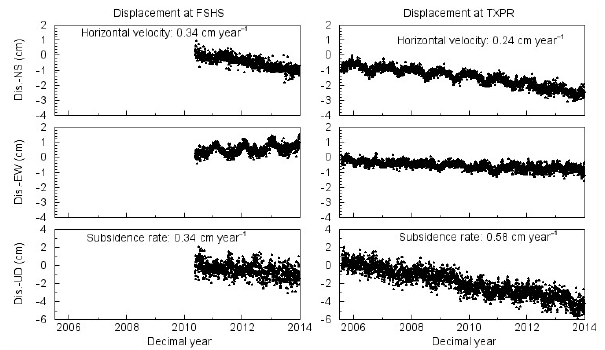
Figure 8. Three-component displacement time series from two CGPS sites with considerable horizontal movements. FSHS is lo- cated at Franklin, Louisiana (Fig. 9a). TXPR is located at Pharr, Texas (Fig. 4). The reference frame is